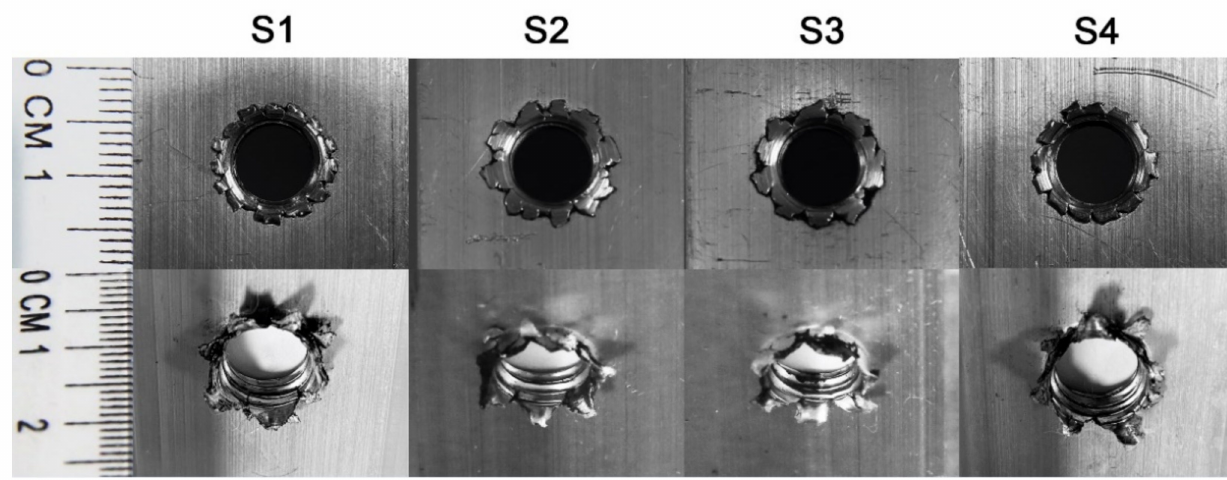
Figure 4. Appearances of flashings (top row) and bushings (bottom row) taken from one of the samples from each